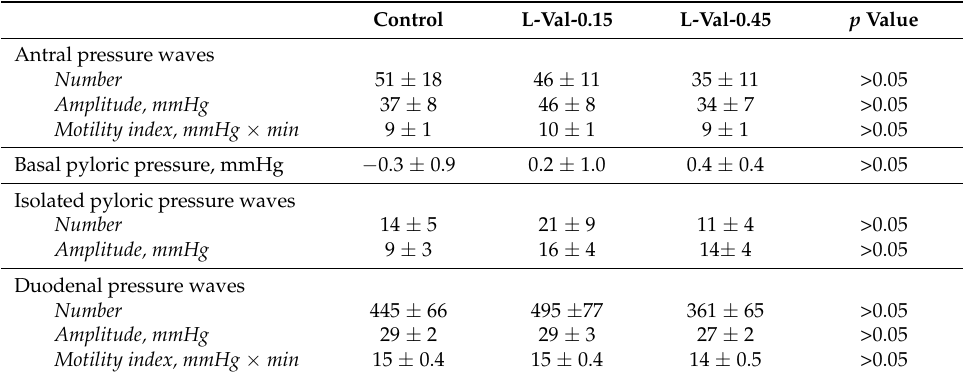
Table 1. Number, amplitude and motility indices of antral and duodenal pressure waves, basal pyloric pressure, and number and amplitude of isolated pyloric pressures waves during 90-min intraduodenal infusions of L-valine at 0.15 kcal/min (“L-Val-0.15”), L-valine at 0.45 kcal/min (“L-Val-0.45”), or control.